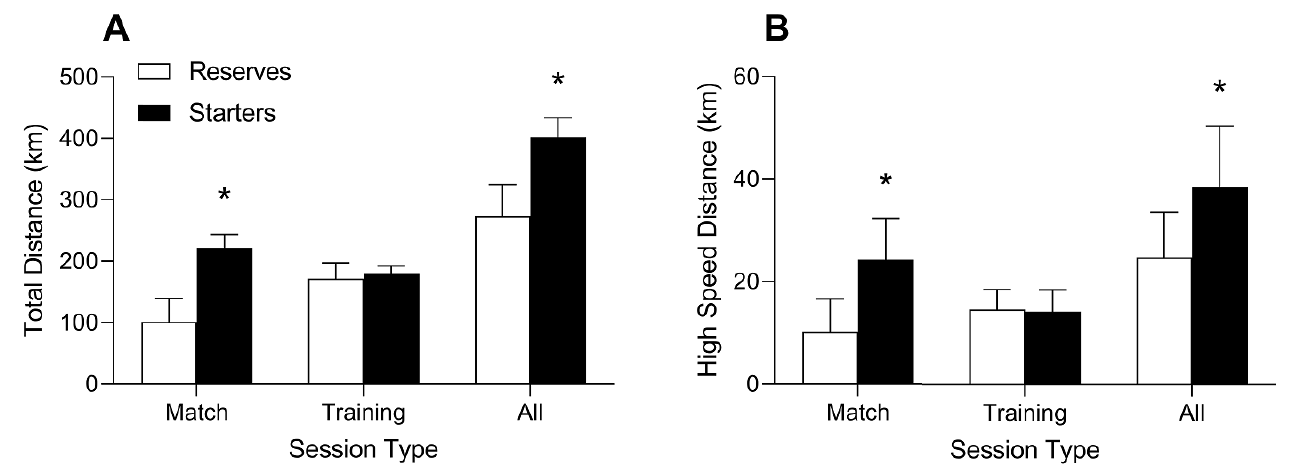
Figure 1. Differences in total distance covered ( A ) and high speed distance ( B ) between starters and reserves in match settings, practice settings, and the cumulative total season. * p < 0.001.